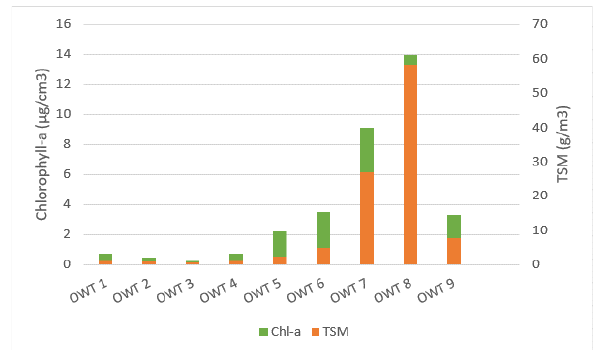
Figure 7. Median chlorophyll-a and TSM concentrations for each OWT